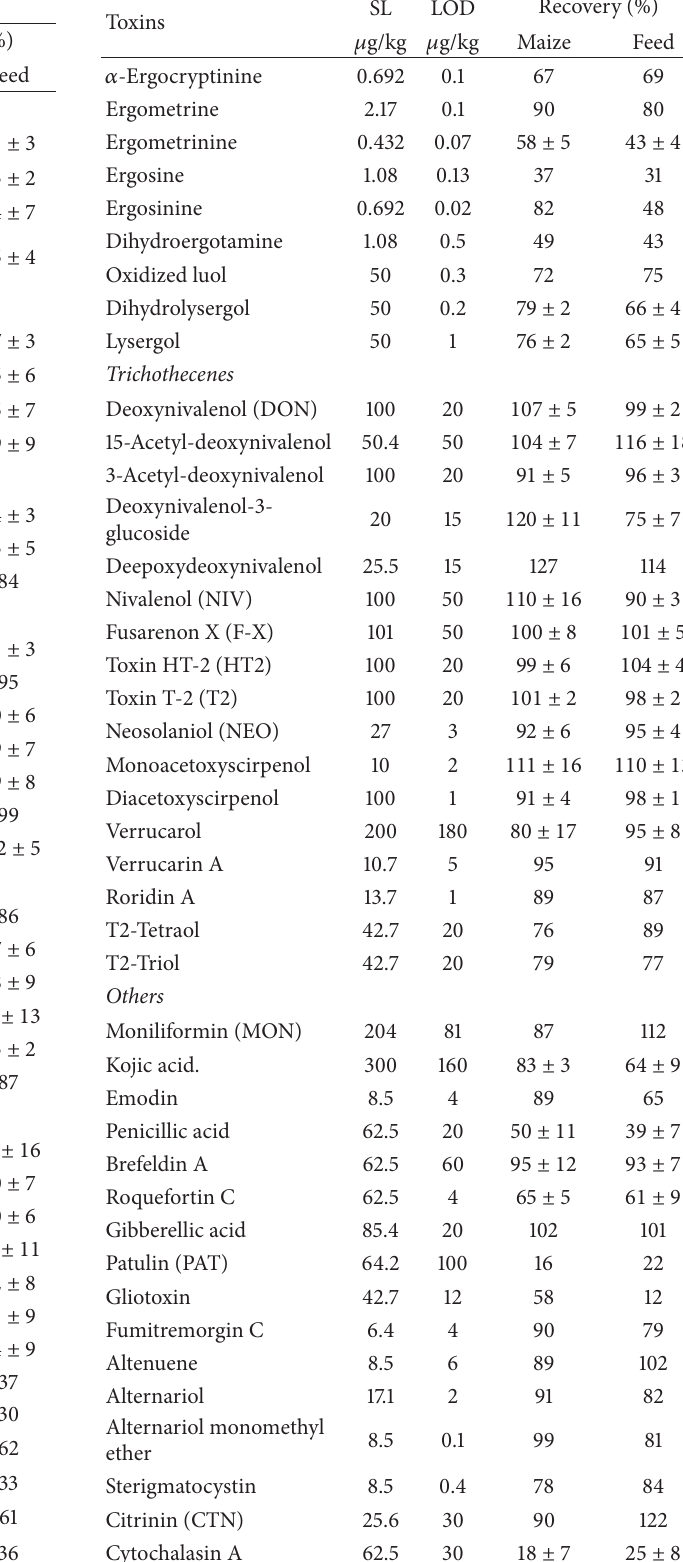
Table 1: Spiking levels (SL), limit of detection (LOD), and average apparent recoveries of spiked maize and